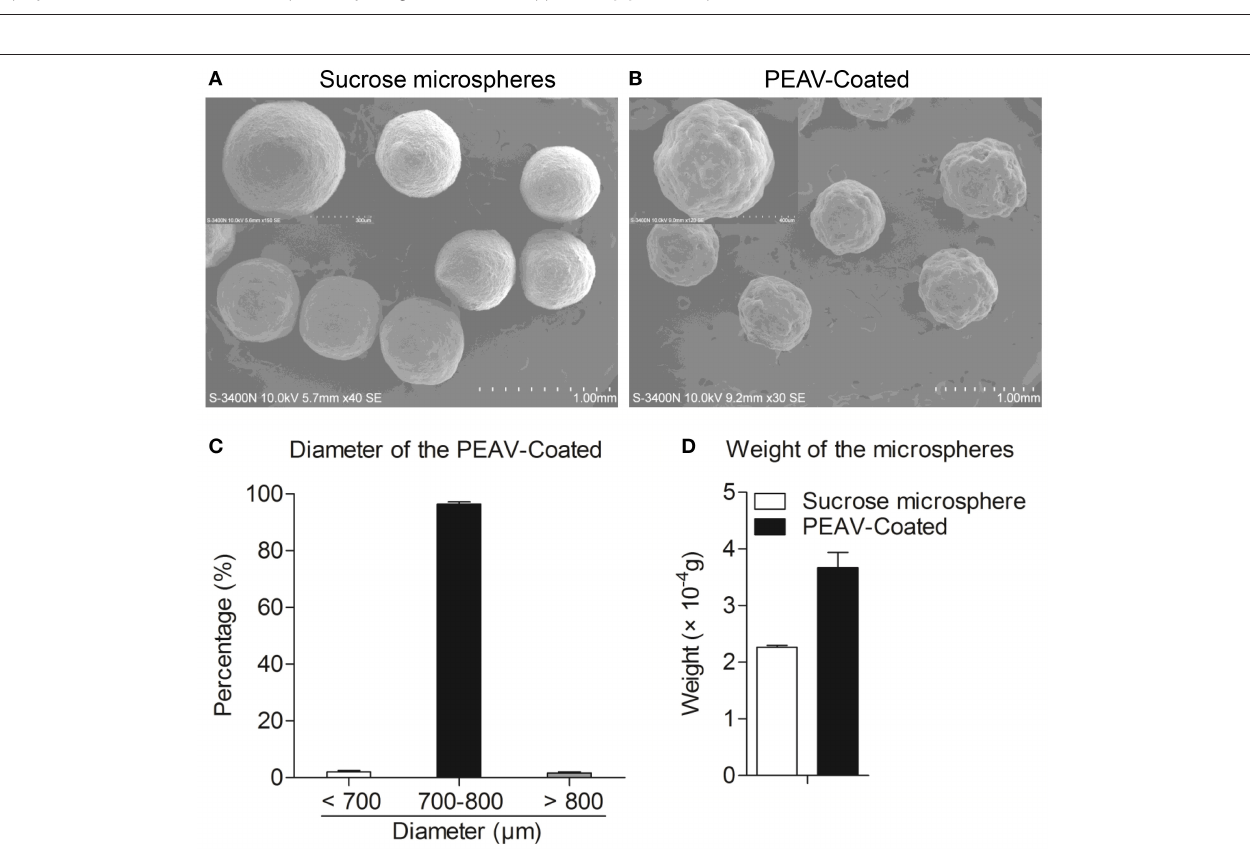
FIGURE 1 | Generation of PEAV-Coated by Centrifugal granulation-fluidized bed coating. (A) The freeze-dried powders containing the PEAV GDS04 strain were loaded onto sucrose microspheres with pure water as an adhesive by using centrifugal granulation technology. The enteric coating (HPMCP) (B) was successively sprayed onto the PEAV-loaded microspheres by using a fluidized bed apparatus. (C) The final product was the PEAV-Coated.